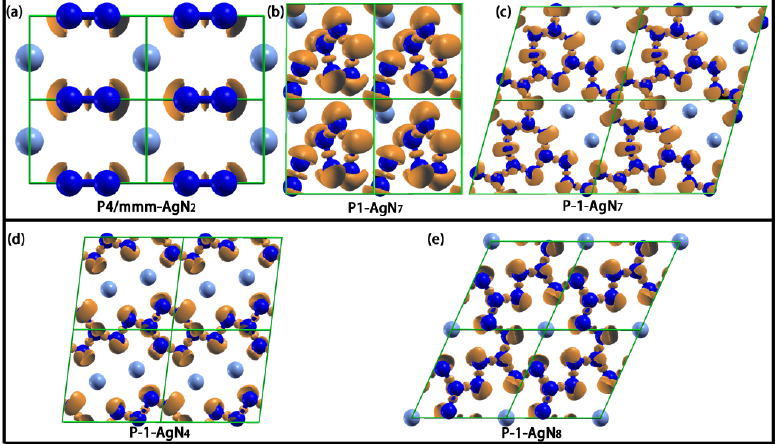
Figure 7. The ELFs of P4/mmm-AgN 2 ( a ), P1-AgN 7 ( b ), P-1-AgN 7 ( c ), P-1-AgN 4 ( d ) and P-1-AgN 8 ( e ) (isovalue = 0.8). Table 2. The Bader charge analysis of P4/mmm-AgN 2 , P1-AgN 7 , P-1-AgN 7 , P-1-AgN 4 and P-1- AgN 8 at different pressures. The negative and positive values mean the donor and the receptor of charge,